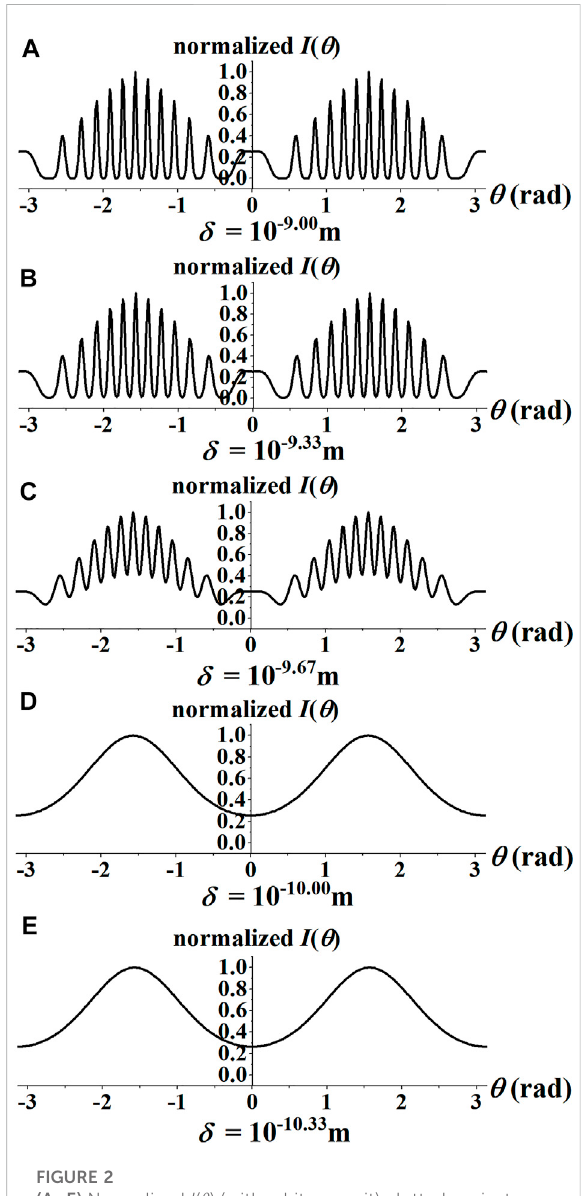
FIGURE 2 (A – E) Normalized I ( θ ) (with arbitrary unit) plotted against θ ≡ arccos ( s · ξ ) for different values of the horizontal coherent length δ . The spot size and the wavelength of the incident radiation are taken to be σ = 4 × 10 − 10 m and λ = 10 − 10.33